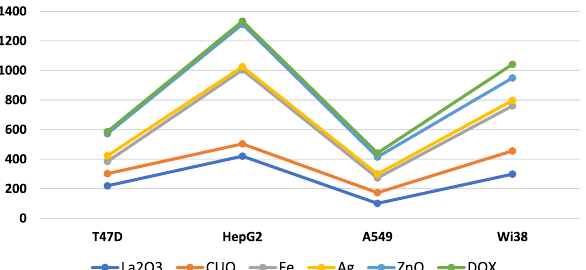
Figure 6. IC 50 of different biosynthesized nanoparticles against various cancer cell lines.